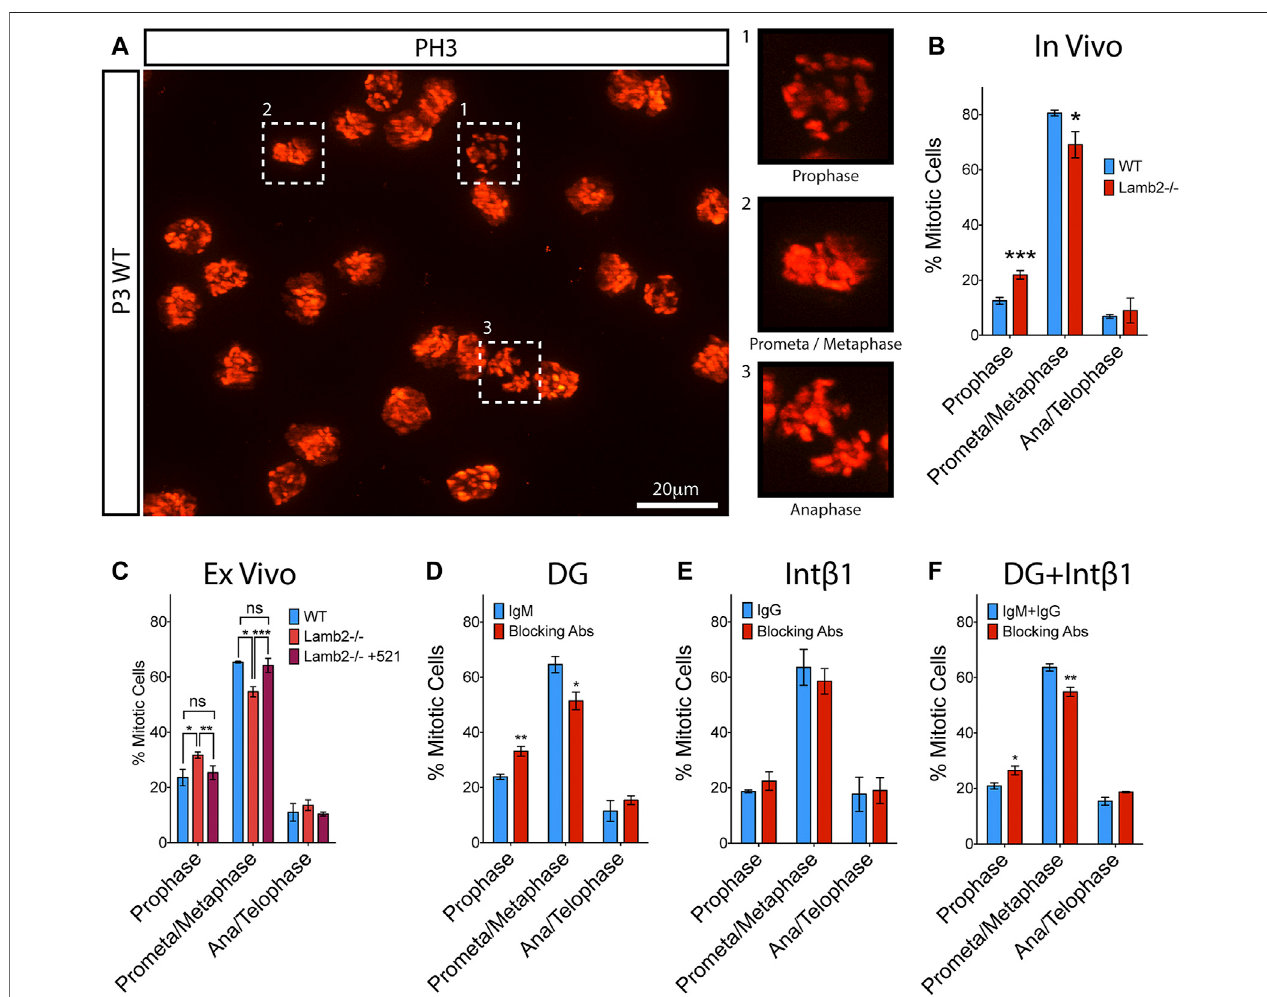
FIGURE 5 | β 2-containing laminins regulate RPC M-phase progression via DG. (A) . Extended focus view of a z stack obtained from the apical surface of a retinal fl at-mount. As PH3 is associated with condensed chromatin, it allows for mitotic staging, based on its staining pattern within the cell. (B) . Quanti fi cation of RPCs in variousstagesofmitosis in WTand Lamb2 − / − retinas. Lamb2 − / − retinas display higher relative percentagesofRPCs inprophase with aconcomitant decrease ofonesin prometa/metaphase, compared to WT. (C) . Quanti fi cation of RPCs in various stages of mitosis in WT and Lamb2 − / − retinal explants. Lamb2 − / − explants display higher relative percentages of RPCs in prophase with a concomitant decrease of ones in prometa/metaphase, similar to in vivo results. Addition of laminin 521 to Lamb2 − / − explants rescues normal mitosis stage ratios. (D) . Quanti fi cation of RPCs in various stages of mitosis in WT retinal explants with and without α -DG